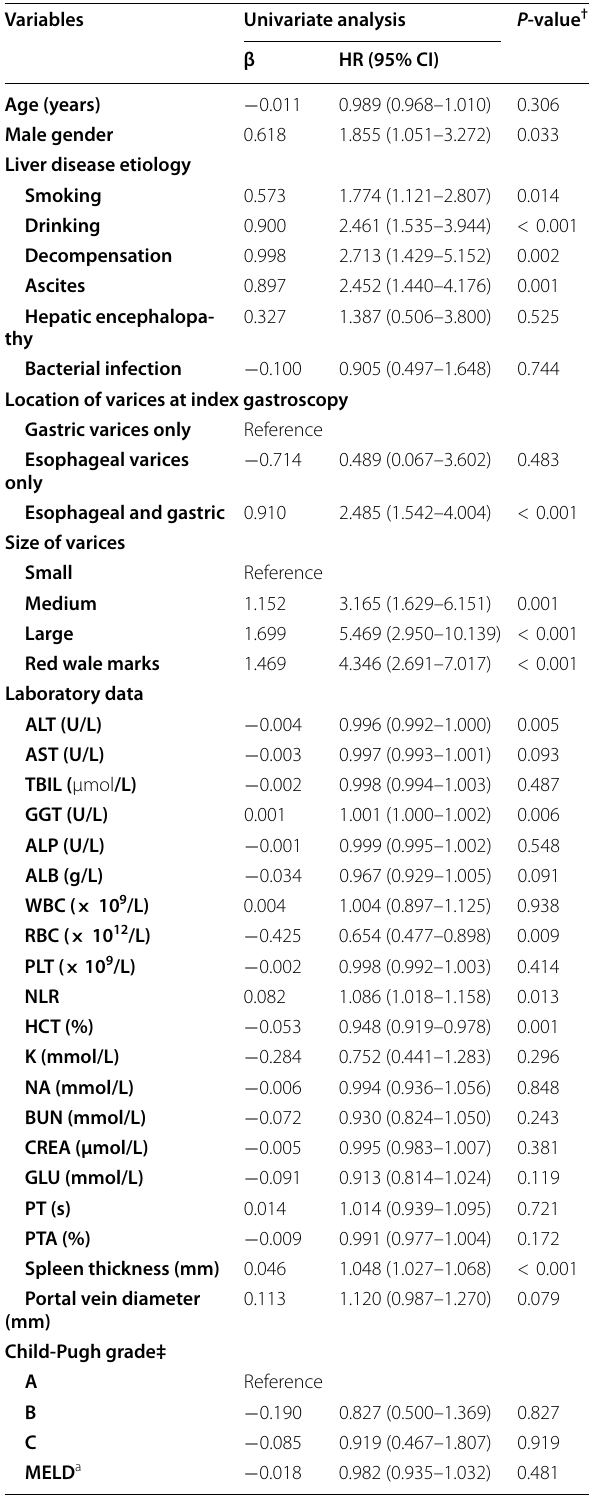
Fig. 2. Multilayer perceptron is a regular ANN struc- ture, comprised of components including input, hidden and output layers [12]. Clinical and biochemical param- eters are included in the input layer (indicated with gray shades in Table 1) with the output layer including a cor- responding prognosis outcome. To improve multilayer perceptron performance, 2 hidden layers after much debugging and testing were added.